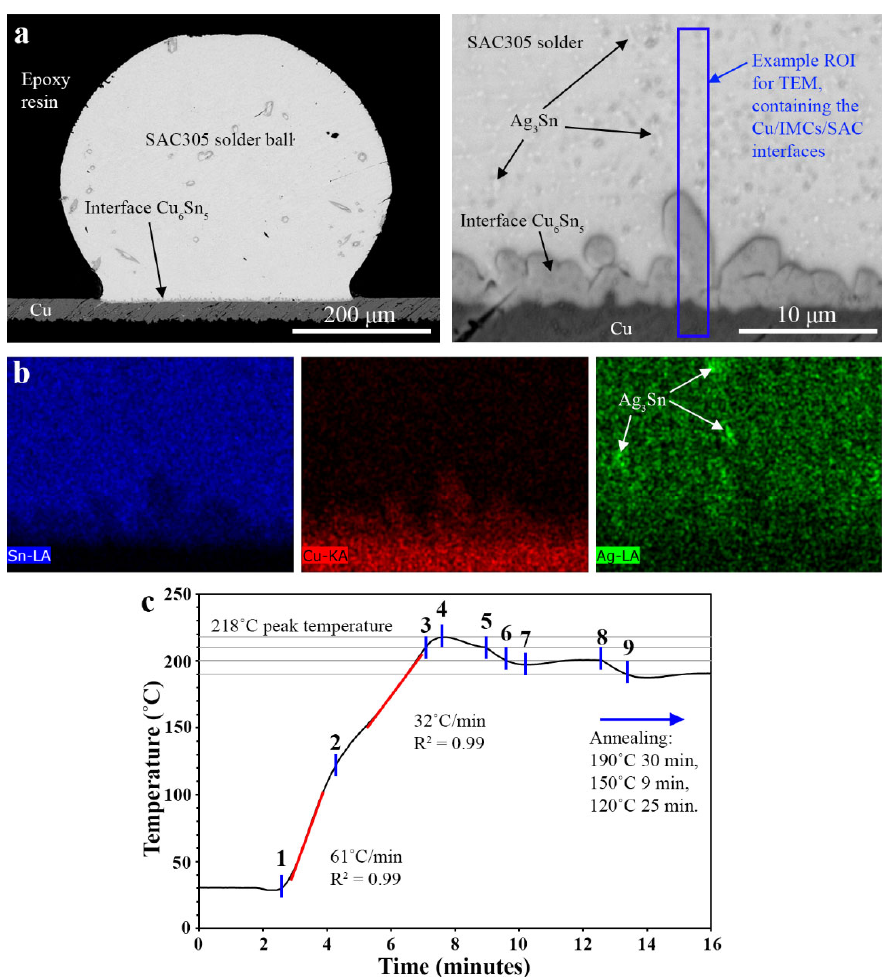
Figure 1. ( a ) SEM cross-section of the as reflowed Cu/IMCs/SAC solder joint at two different magnifications. ( b ) Sn, Cu and Ag EDS maps of the Cu/IMCs/SAC solder joint. ( c ) Temperature profile of the heating experiment, showing different time intervals (points 1–9) through the heating